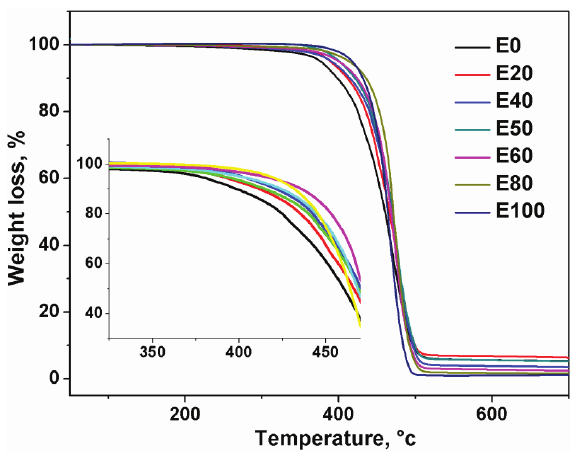
Figure 5: TGA profiles of pristine polymers and EMA/NBR blends.